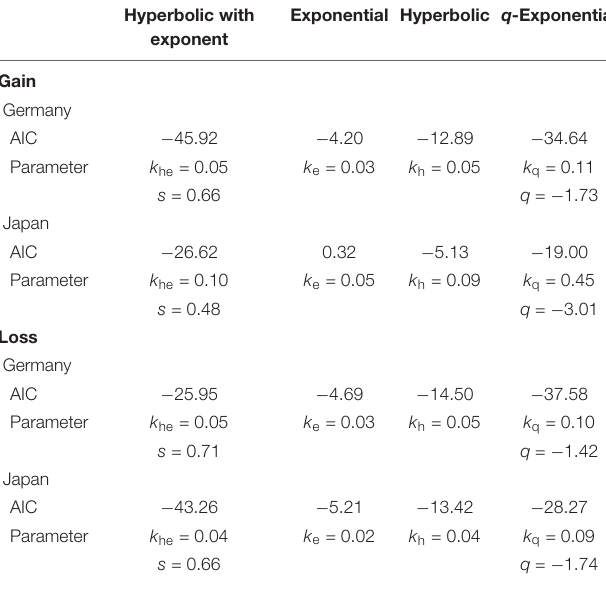
TABLE 1 | AIC and parameters for four models.